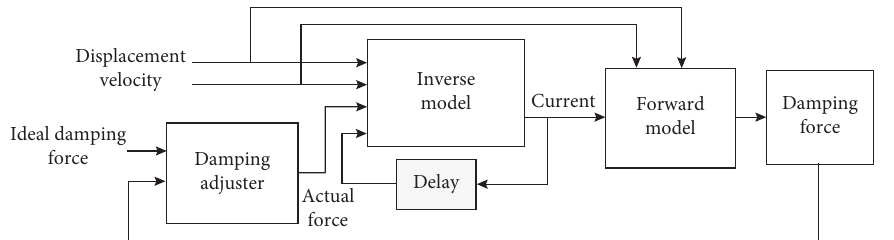
Figure 7: The control module of the MR